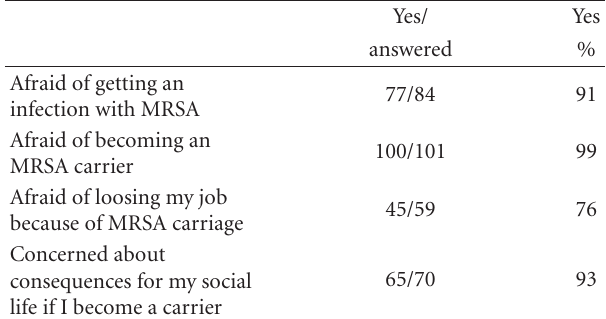
Table 1: Reasons for being concerned about MRSA among nurses.